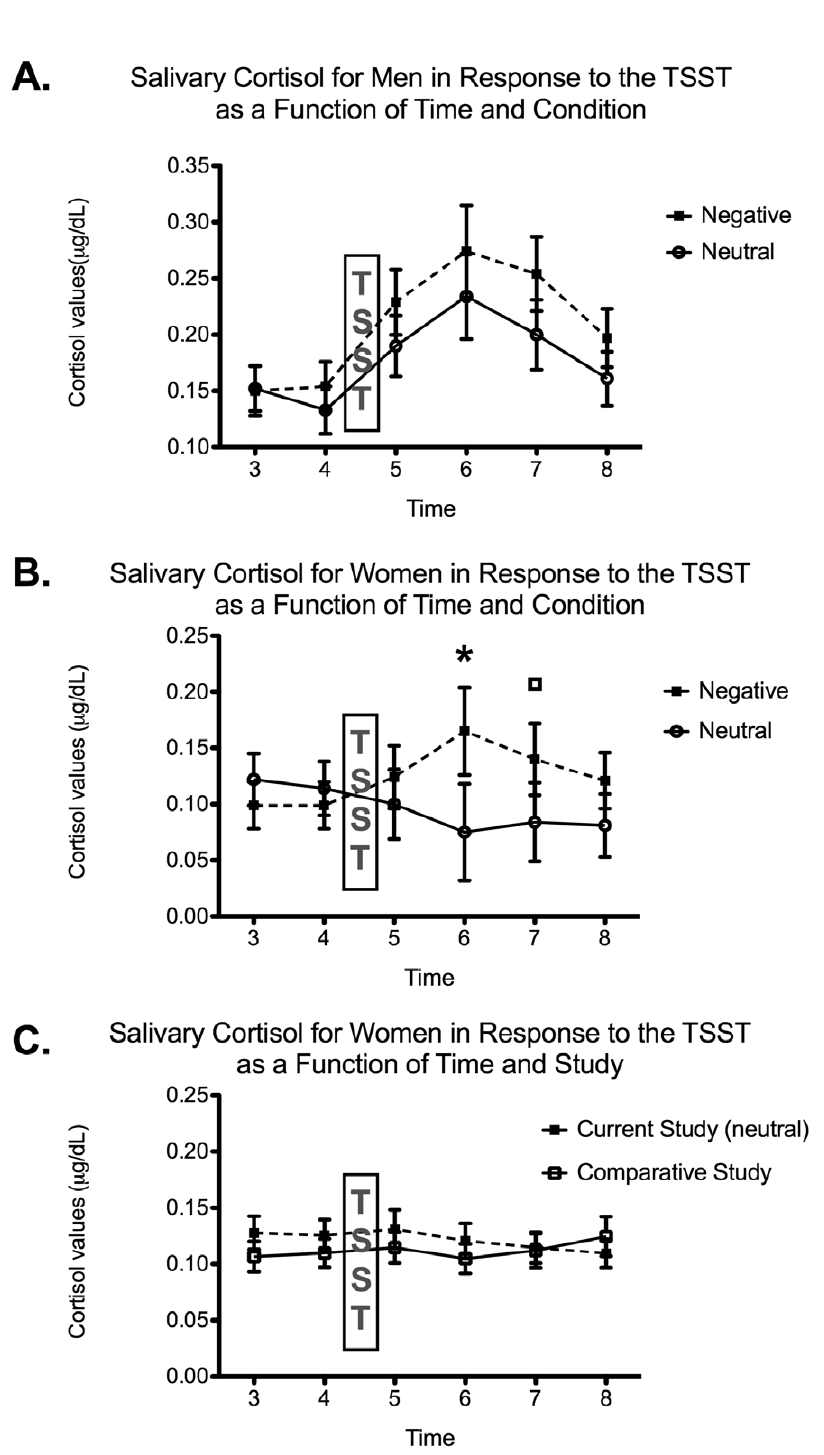
Figure 2. Mean salivary cortisol levels in response to the Trier Social Stress Test as a function of Time (Time 3– pre-anticipation, Time 4– post-anticipation, Time 5, 6,7 and 8–0, 10, 20 and 30 minutes following the end of the TSST) and Condition (neutral, negative) for men (panel A) and women (panel B). Adjusted means as a function of ‘emotionality’ and ‘concerned’ are presented. The error bars represent the standard error of the mean. The asterisk (*) means p , 0.05 and the square ( % ) stands for trend towards significance (p=0.072). Panel C depicts mean salivary cortisol levels in women in response to the Trier Social Stress Test as a function of Time (Time 3– pre-anticipation, Time 4– post- anticipation, Time 5, 6,7 and 8–0, 10, 20 and 30 minutes following the end of the TSST) and Study (current study – group of women neutral vs. comparative study – group of women). The raw means are presented. The error bars represent the standard error of the mean.